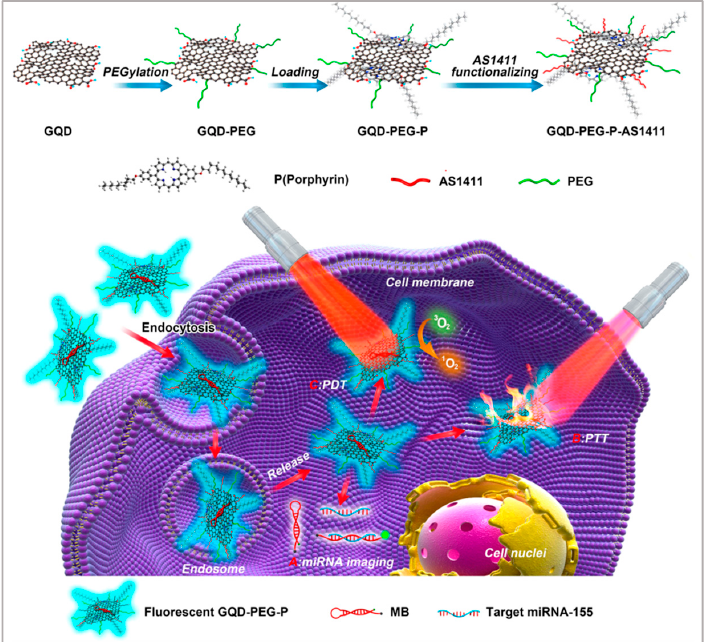
Figure 8. Synthesis of GQD-PEG-P for the combined photothermal/photodynamic therapy. Reprinted with permission from [110]. Copyright © 2016 American Chemical